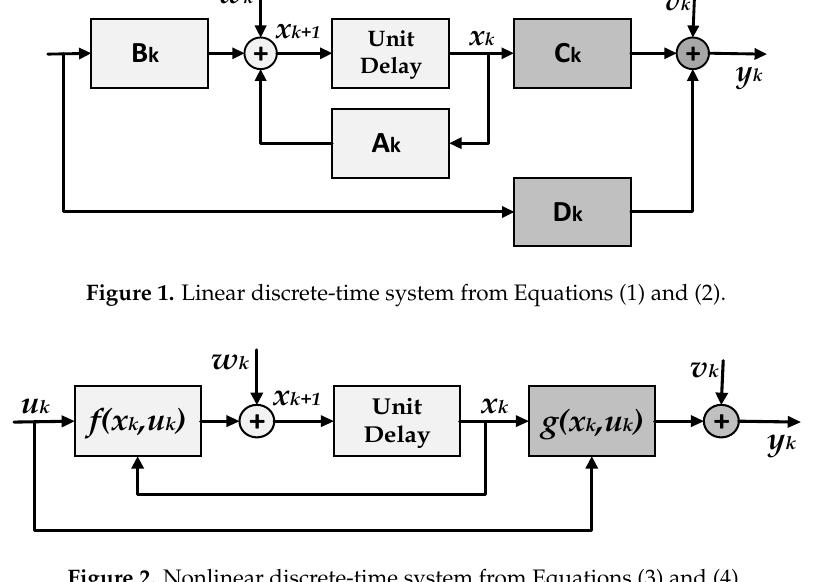
Figure 2. Nonlinear discrete-time system from Equations (3) and (4).